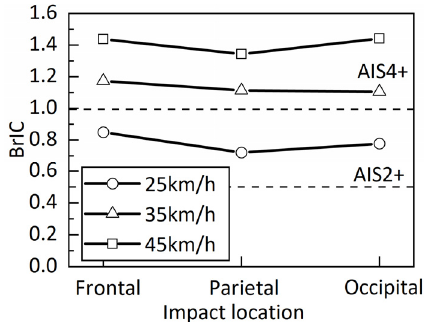
Figure 9. Comparison of resultant acceleration (filter of 1000 Hz) with parietal impact contrecoup side between fracture and non-fracture models at 35 km/h.